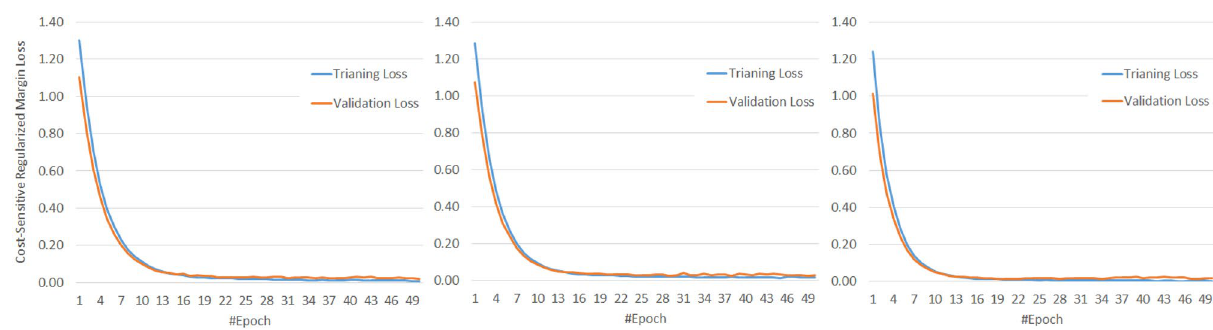
Figure 5. The cost-sensitive regularized margin loss (error) of our RegCS.CapsDenseNet method with three k-fold validations. (left) k = 4, (center) k = 5, and (right) k = 10 on the COVID-CT